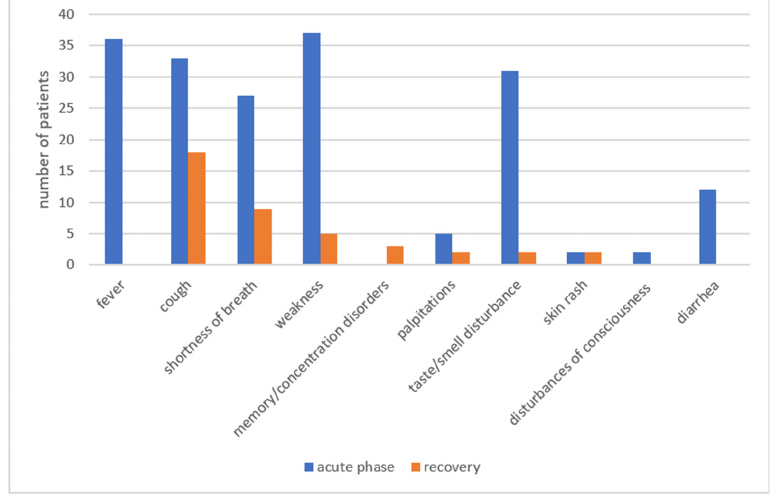
Figure 1. Group I—symptoms in the acute phase and 6 months after COVID-19.